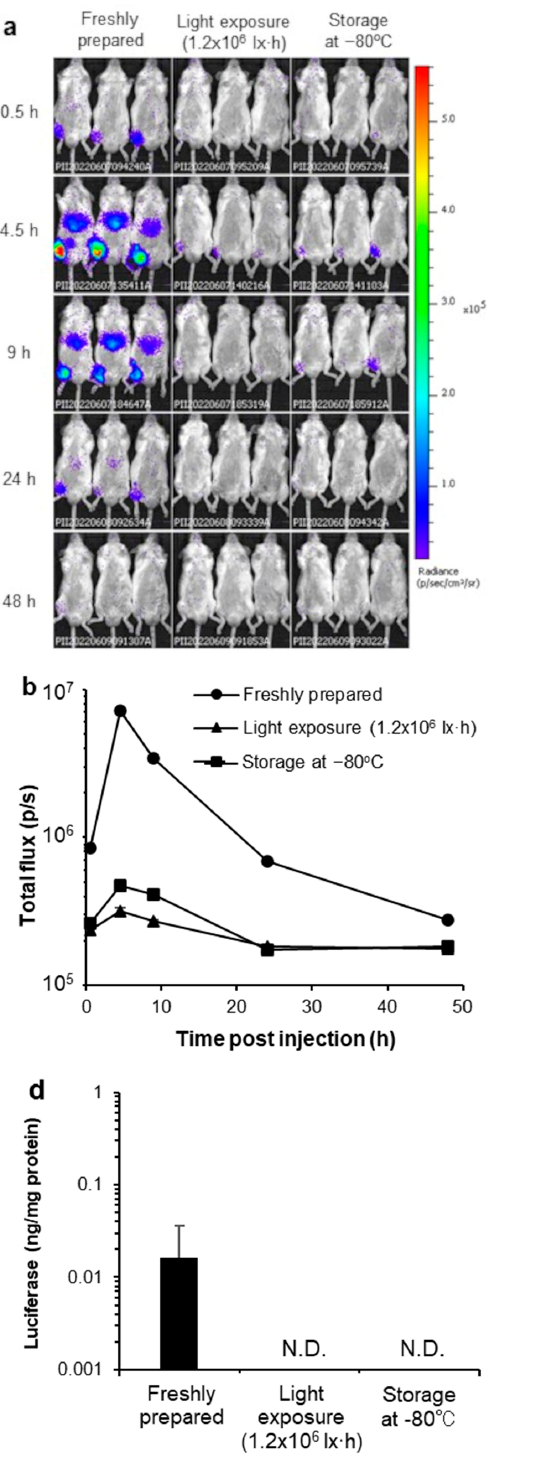
Figure 7. Effects of storage condition for the expression kinetics of firefly luciferase encoded mRNA-LNP and in vivo luciferase assay. ( a ) the duration and translational pattern of mRNA-LNPs were freshly prepared, exposed to the light of 1.2 × 10 6 lx·h, and stored at − 80 °C without cryoprotectants. The total flux in the region of interest (ROI) at ( b ) the abdominal region and ( c ) their right leg as the